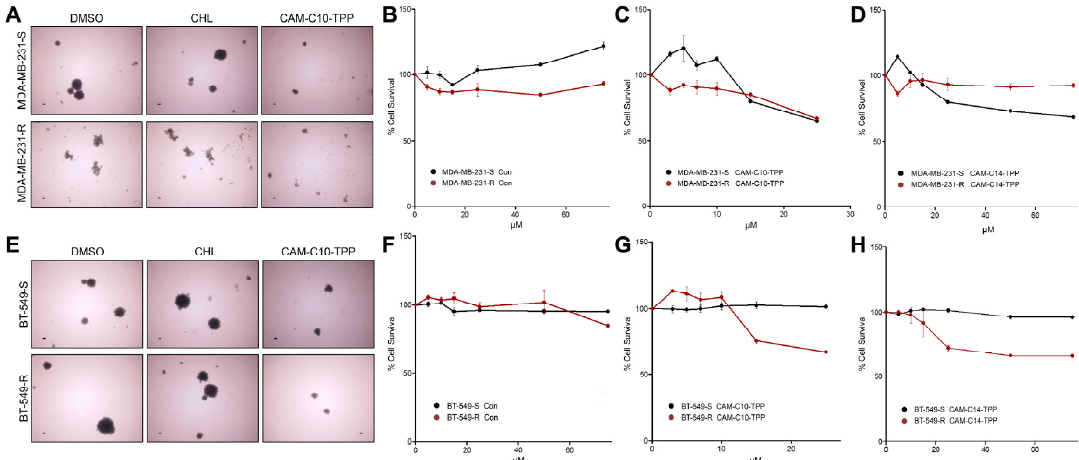
Figure 6. Effect of CAM-TPP derivatives on the cell viability of CSC-like TNBC cells. MDA-MB-231 ( A – D ) and BT-549 ( E – H ) TNBC-sensitive (S) and chemoresistant (R) cells were grown under non-adherent conditions for 5 days in the presence of CAM-TPP derivatives to form spheroids. Representative images ( A , E ) of CAM-C10-TPP-treated cells show a decrease in spheroid size. CSC-like cells were then tested for viability as before. The results are the mean of 3 independent experiments. The data indicate the mean ± SEM. The p -values, all relative to controls, were statistically significant ( p <